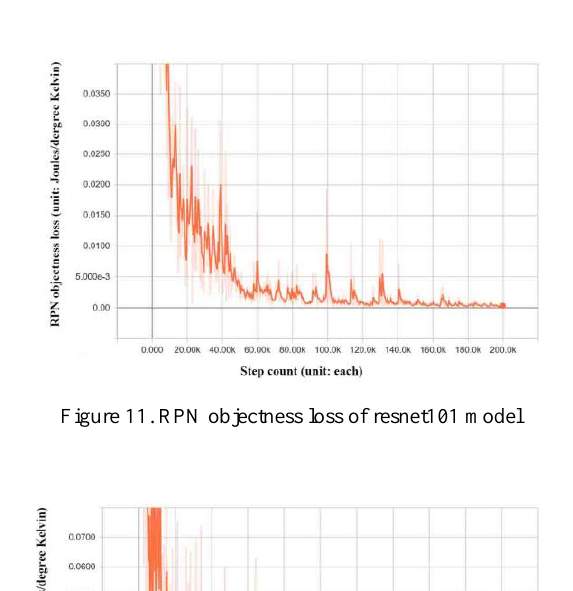
Figure 8. Global step time cost of resnet-v2 model